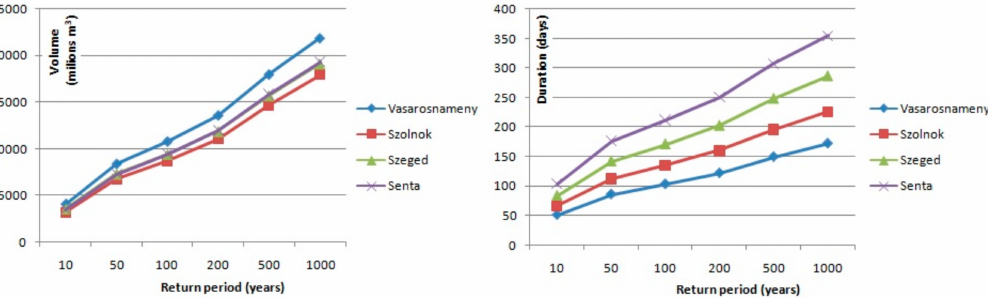
Figure 8. Flood volumes and durations of the Tisa River in the Pannonian Basin.